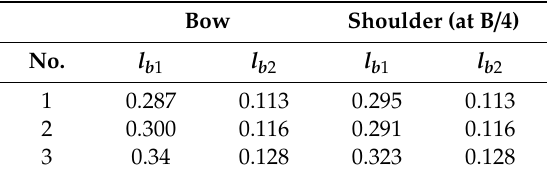
Table 5. Ice breaking length result summary and comparison (unit: m).